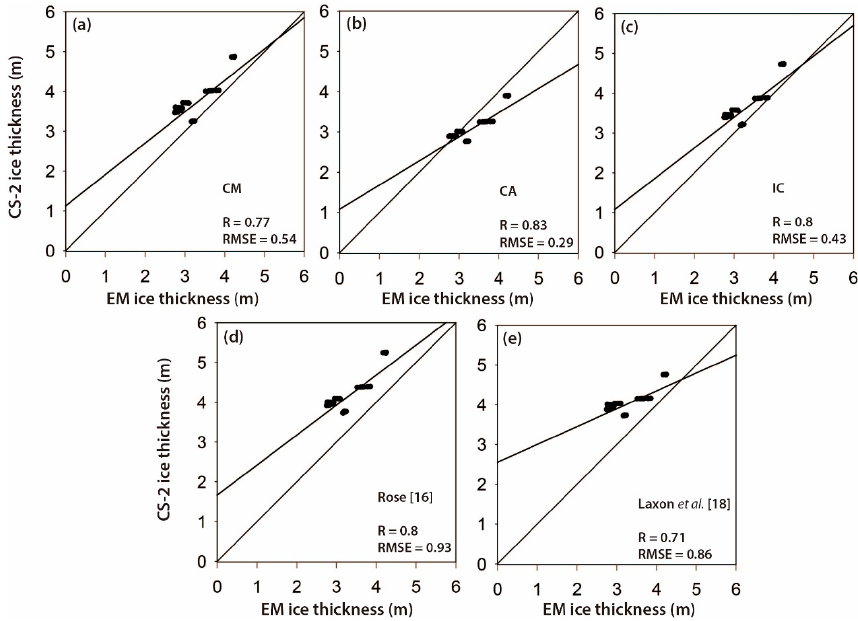
Figure 11. Scatterplots between the CryoSat-2-derived sea ice thickness and the averaged AEM-bird Figure 11. ( a – e ) Scatterplots between the CryoSat-2-derived sea ice thickness and the averaged ice thickness for validation. AEM-bird ice thickness for